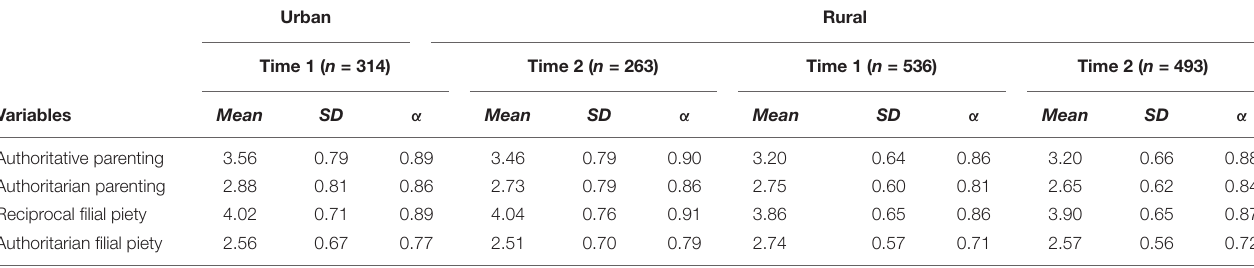
TABLE 2 | Descriptive statistics of the study variables.